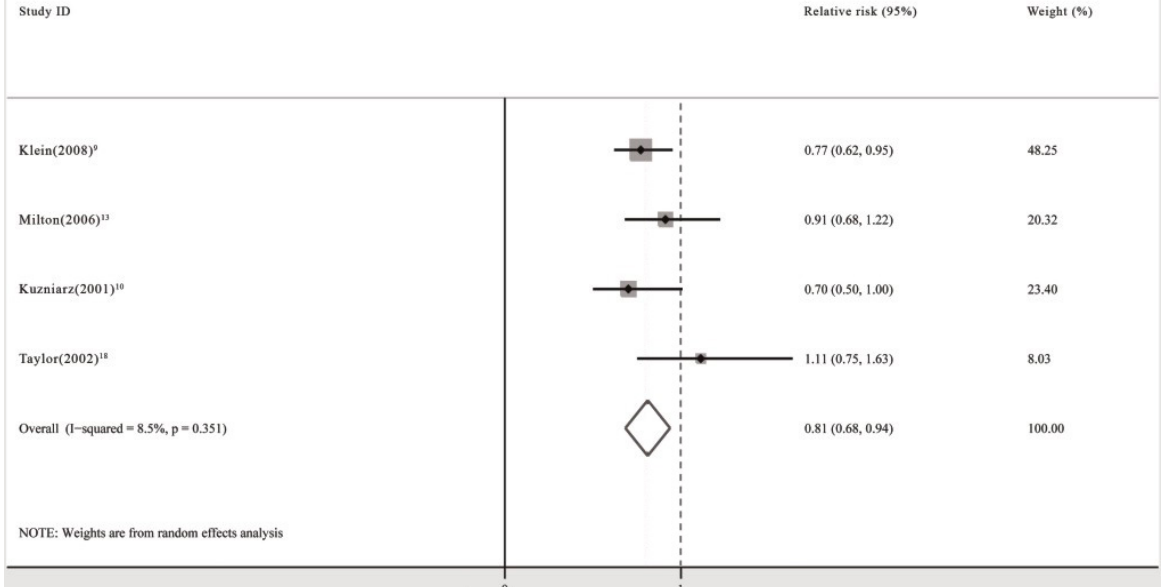
Figure 3. Pooled relative risk (95% CI) of cortical cataracts comparing the longest duration of multivitamin/mineral supplementation with no